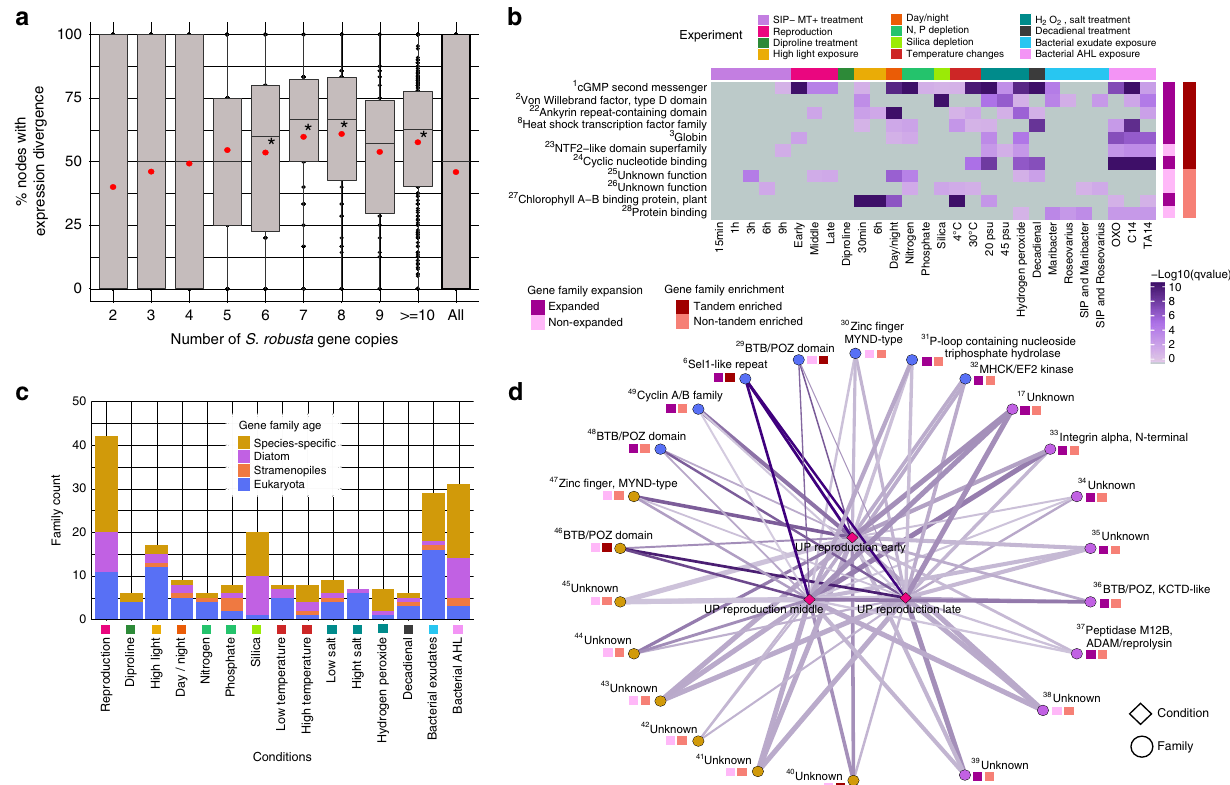
Fig. 3 Expression analysis for S. robusta multi-copy gene families. a Expression divergence trend for multi-copy S. robusta families ( n = 4444 families). The y axis denotes the percentage of nodes showing expression divergence in the phylogenetic tree of the family, while the x axis represents the number of S. robusta gene copies in the family. Average expression divergence percentages are indicated by red dots. Median expression divergence values signi fi cantly higher than the median of all nodes are highlighted with a star ( P -value < 0.05, Wilcoxon rank-sum test, two-sided). b Heatmap showing pleiotropic families signi fi cantly enriched in upregulated genes for more than seven different conditions. The x axis represents the different conditions/ experiments, whereas the y axis reports the families. The signi fi cance of the upregulation in a certain condition for a family is shown in – log 10 ( q -value) scale highlighted by a color gradient from gray to dark purple. Expansion and tandem enrichment of each family are highlighted in different colors on the right side of the heatmap. c Barplot showing family counts with signi fi cant condition-speci fi c expression. The x axis represents the different conditions/ experiments, whereas the y axis represents the number of families having signi fi cant expression bias for that condition. The color of the bars denotes the family age distribution. d Network showing families with signi fi cant speci fi c expression in the three reproduction stages available. Families are represented with circles, while conditions are represented with diamonds. The color of the circles denotes the family age following the same color code as panel c . The edge ’ s width denotes the fraction of genes in the family that shows upregulation for the given condition, while the edge ’ s color represents the signi fi cance of the enrichment, following the same color code as panel b from gray to dark purple. Expansion and tandem enrichment of each family are indicated by the squares next to the gene family circles, also following the same color code as panel b . Source data are provided as a Source Data fi le. Numbers